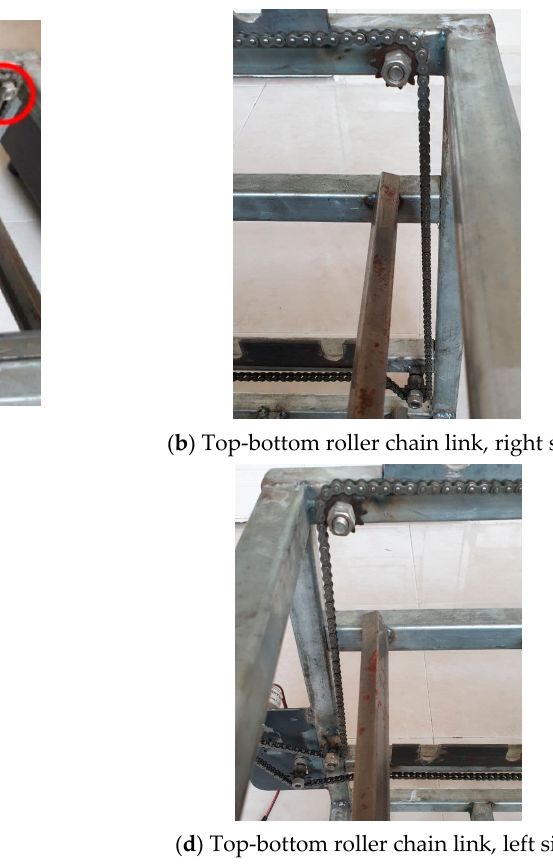
Figure 7. Sprocket ‐ roller chain mechanism. Figure 7. Sprocket-roller chain mechanism.